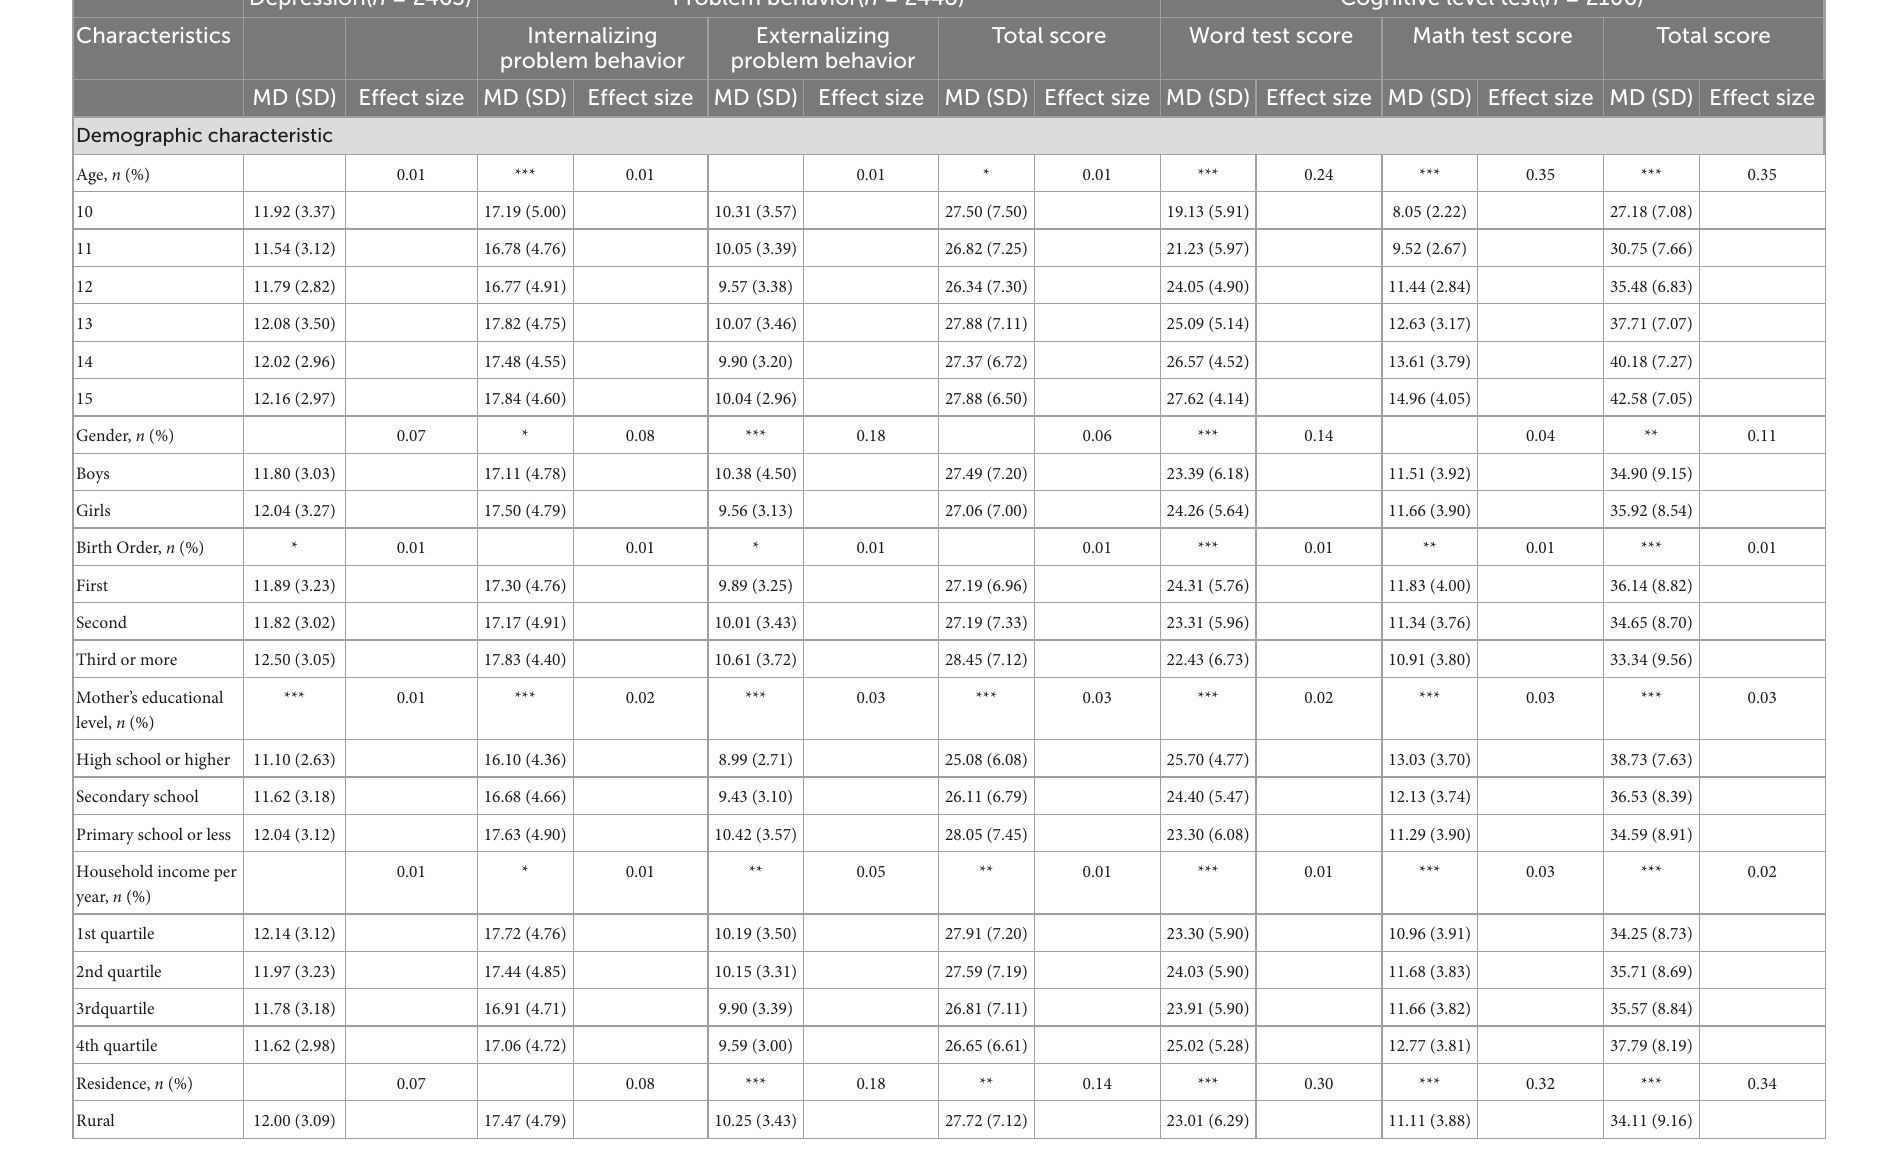
TABLE 2 Differences in the average scores of depression test ( n = 2,463), problem behavior test ( n = 2,448), cognitive level test( n = 2,106). Depression( n = 2463) Problem behavior( n =